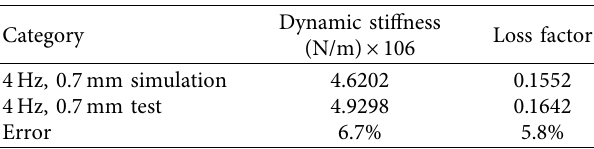
Figure 13: Strain cloud diagram of shaft damping ring. Table 4: Dynamic characteristics simulation and test comparison of shaft damping